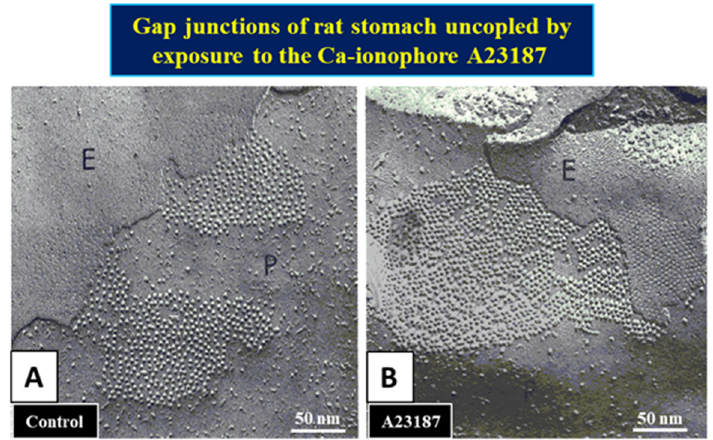
Figure 14. Freeze fractures of rat stomach gap junctions. In samples fixed immediately or kept for 1 hr in an oxygenated saline at 37 °C the gap junctions show channels irregularly arranged at center- to-center spacings of 103–105 Å ( A ). In contrast, in samples kept in salines containing 2 µM A23187 (Ca 2+ -ionophore), the channels pack into crystalline, hexagonal arrays with average center-to-center spacings of ~85 Å ( B ). Adapted from ref. [18].